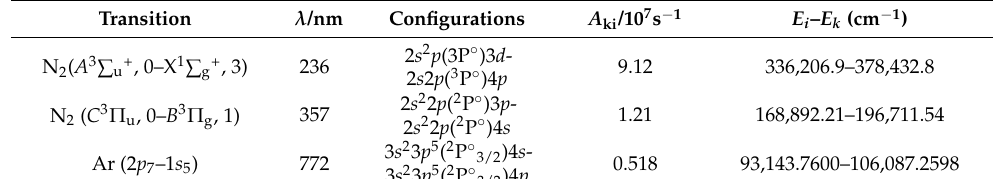
Table 1. Parameters of the argon and nitrogen spectral lines studied in the experiment.